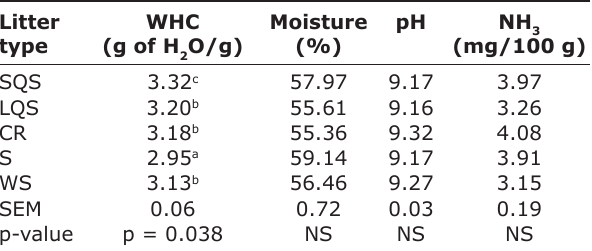
Table-4: Physicochemical properties of different litter materials on 42 days. Litter type